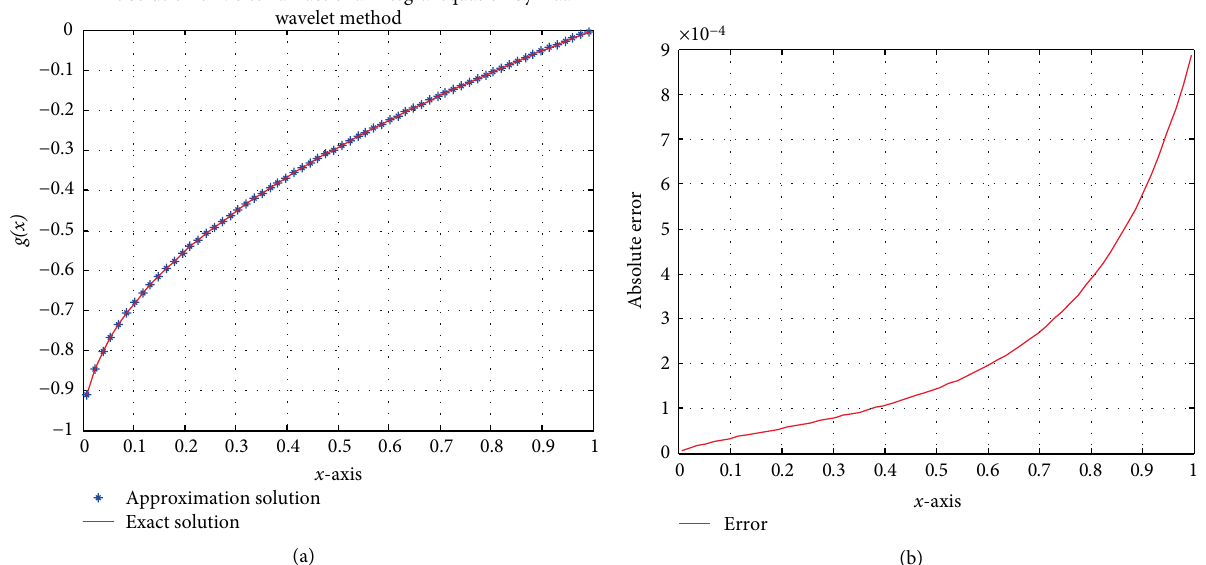
Figure 1: A comparison and absolute error between exact and numerical solutions in Example 1 with 𝑁 = 64 . (a) A comparison. (b) Absolute error.